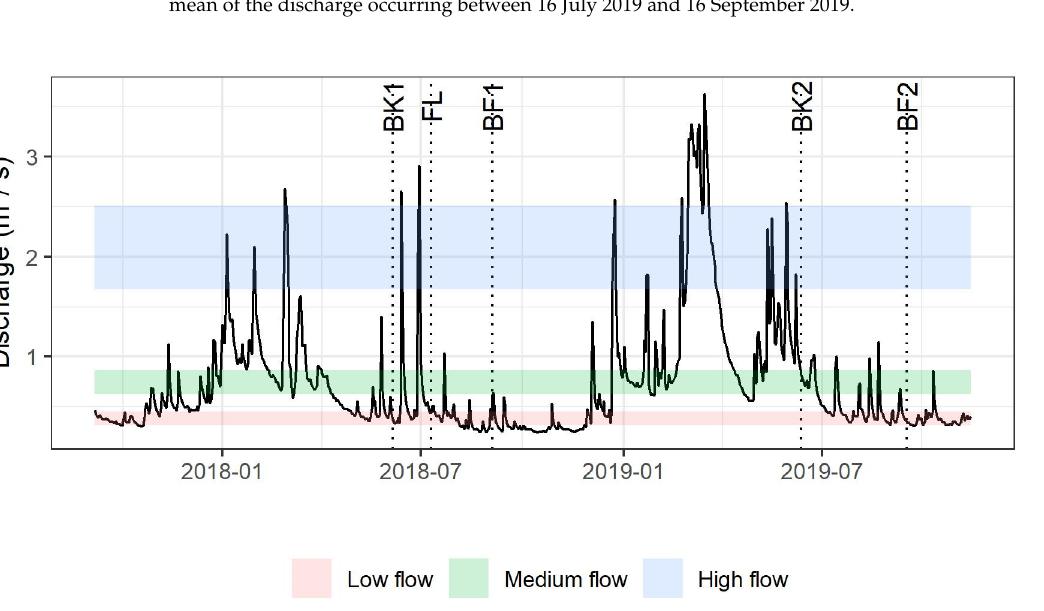
Figure 2. Discharge recorded by the gauging station in Leopoldschlag for the period the sampling was conducted. The dotted vertical lines indicate the day samples were collected. BK = bankfull, BF = baseflow, FL = flood. The horizontal bands indicate the interquartile range of the yearly flow percentiles for low (10th), medium (50th), and high (90th) flow, calculated for the years 1991–2016.